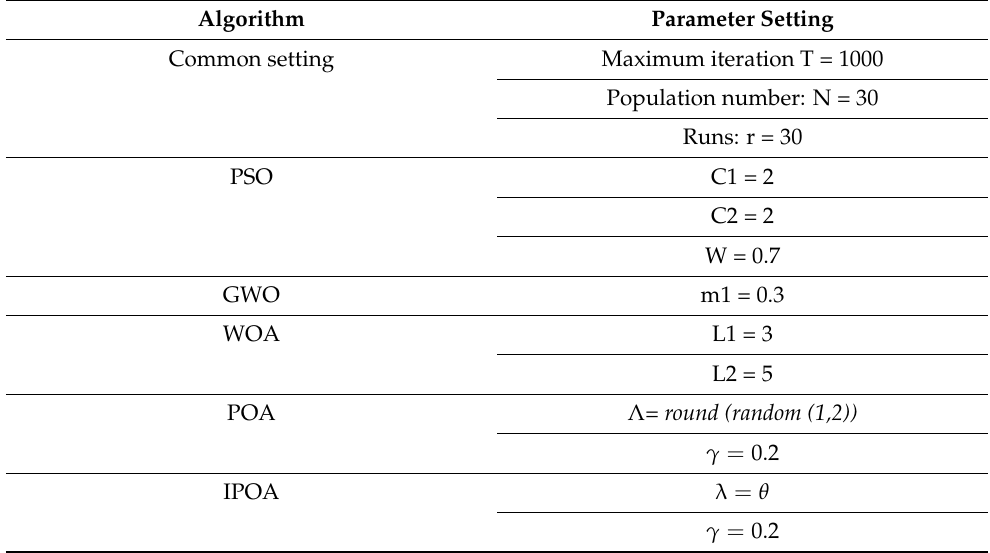
Table 1. Parameter setting of PSO, GWO, WOA, POA, and